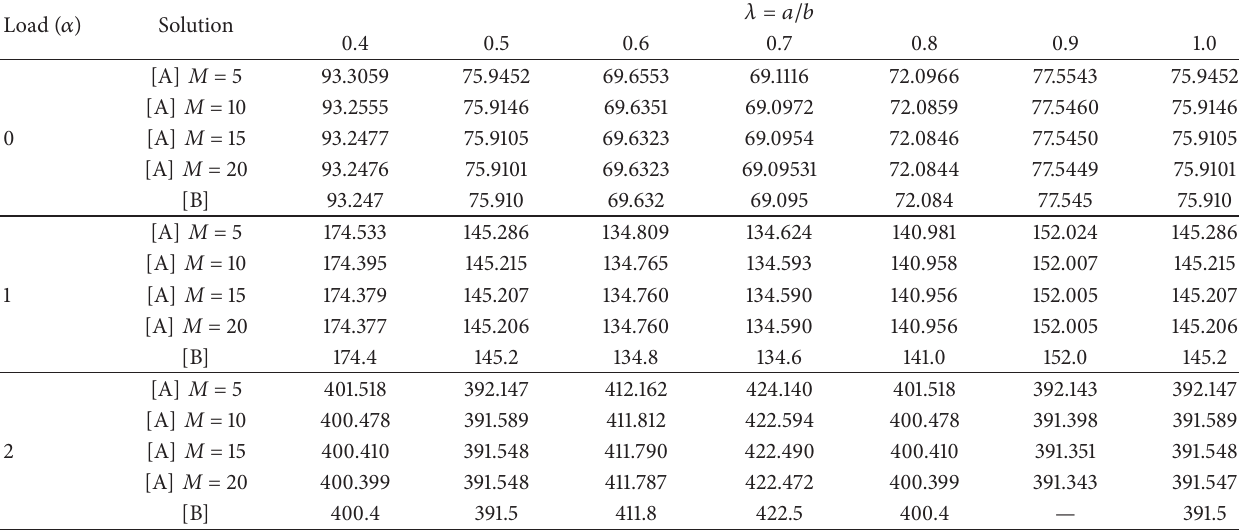
= 𝑁 𝑏 2 /𝐷 for a SS-C-SS-C plate. crit crit